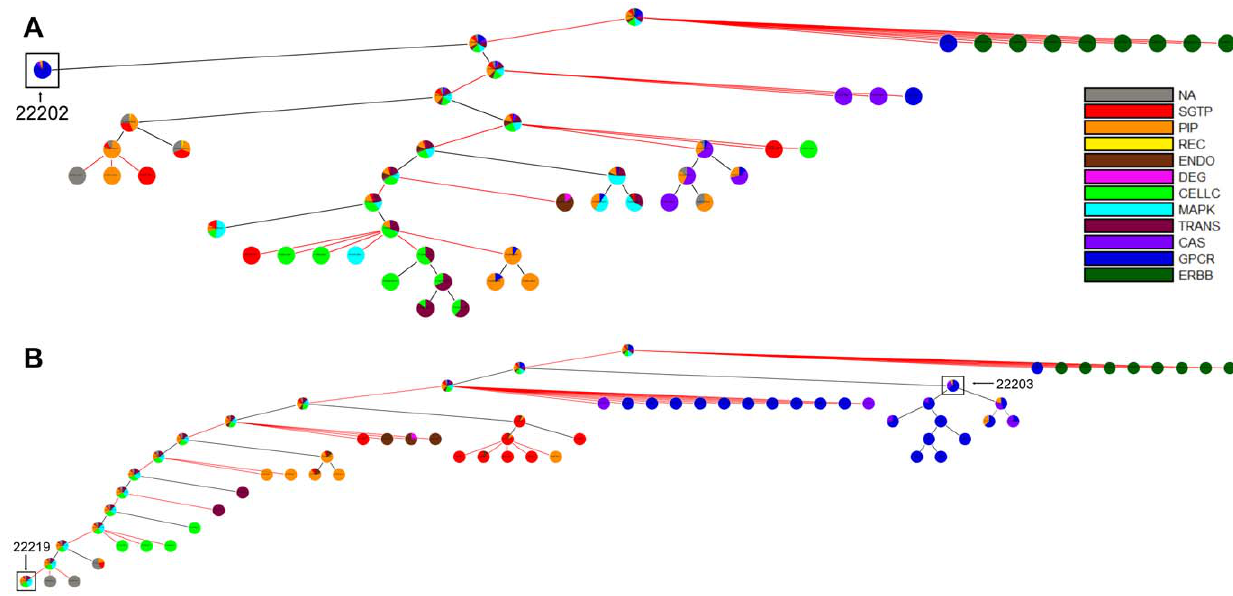
Figure 3. Hierarchical partitions of EGFR signaling network. (A) Partitions obtained using Newman’s connectivity metric. The GPCR dominated module (ID: 22202) has 36 reactions and 28 cycles. (B) Partitions obtained using the ShReD metric. The GPCR dominated module (ID: 22203) has 39 reactions and 167 cycles. The terminal node (ID: 22219) has 99 reactions, but only 10 cycles.